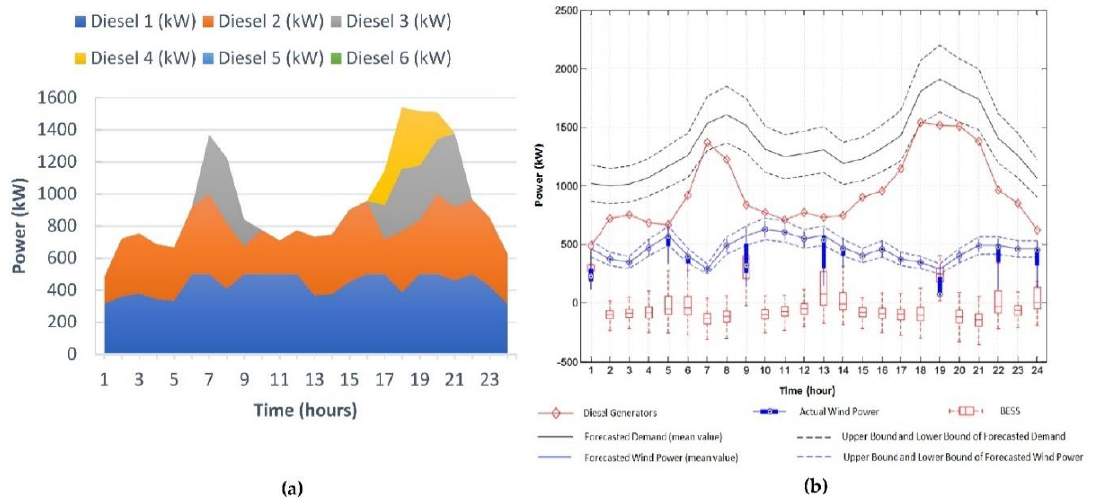
Figure 7. Case 1a (frequency criteria not considered): ( a ) optimal daily schedule for the DGs and ( b ) box plots of wind power, ESS power, DG power, and forecasted demand.